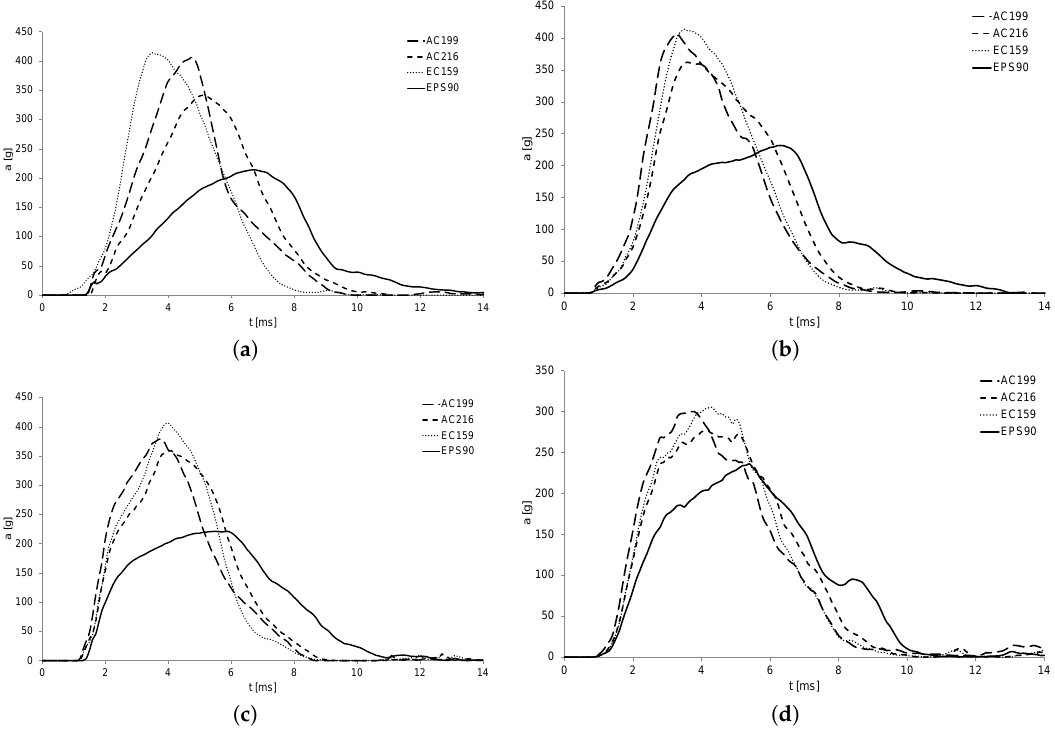
Figure 4. Acceleration measured in the headform’s COG - ECE 22.05 test conditions: ( a ) Impact point B. ( b ) Impact point P. ( c ) Impact point R. ( d ) Impact point